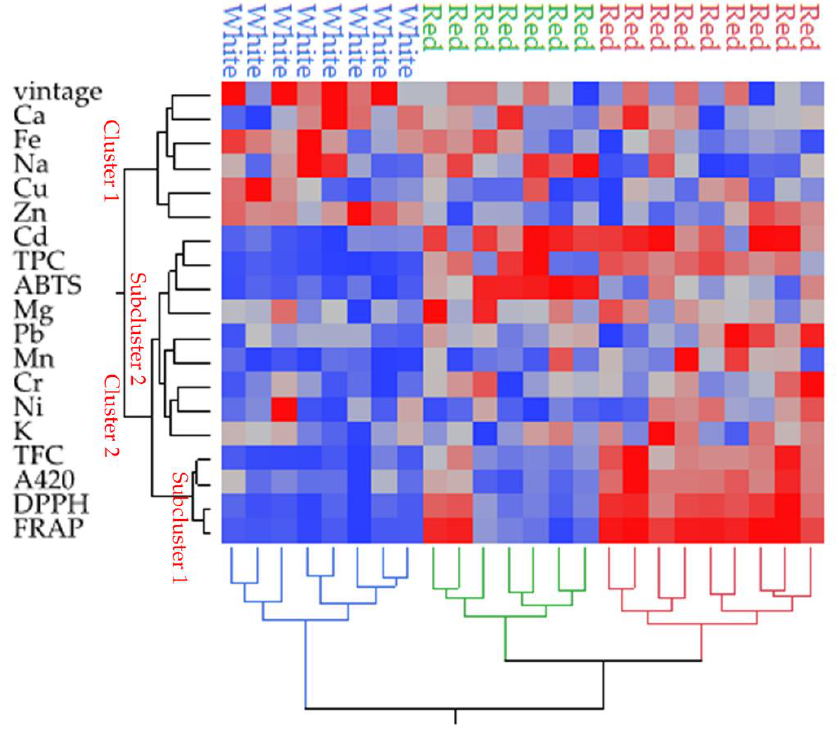
Figure 1. Dendrogram of two-way clustering of wines based on the variables measured in wines using Ward’s method on the standardized data to define distances between clusters. Blue areas in the map dendrogram indicate low values whereas the red areas indicate high values.